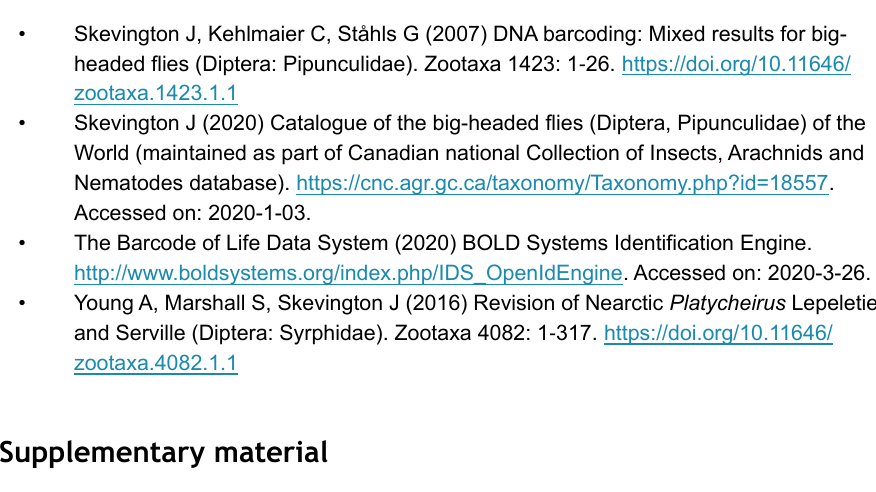
Suppl. material 1: Uncorrected pairwise distances amongst Eudorylas species in the Middle